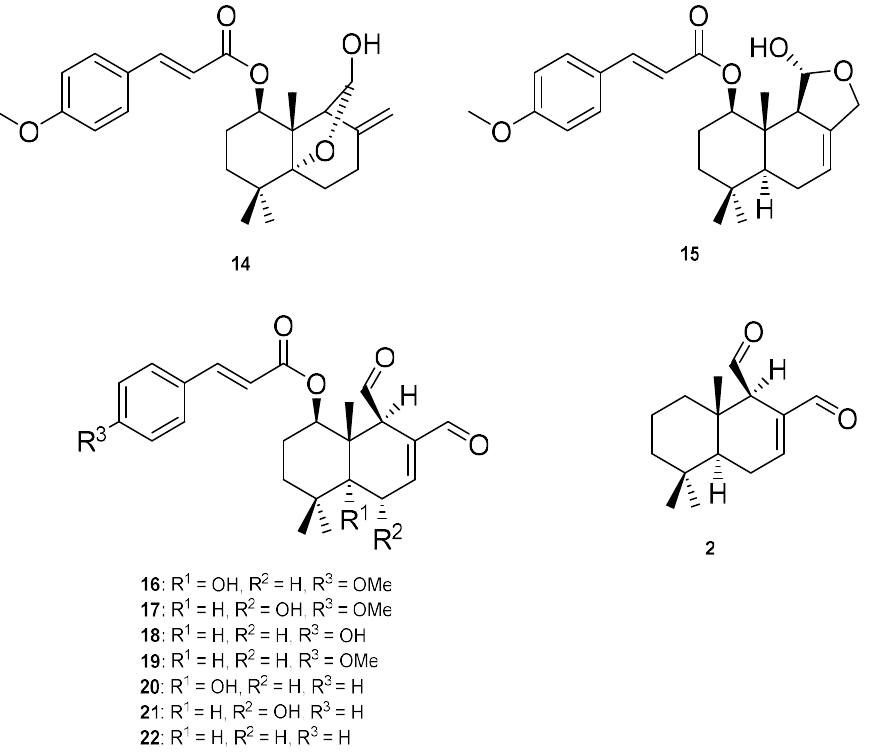
Figure 5. Cytotoxic drimanes from Drimys brasiliensis , Zygogynum pancheri , and Zygogynum acsmithii [48–50].